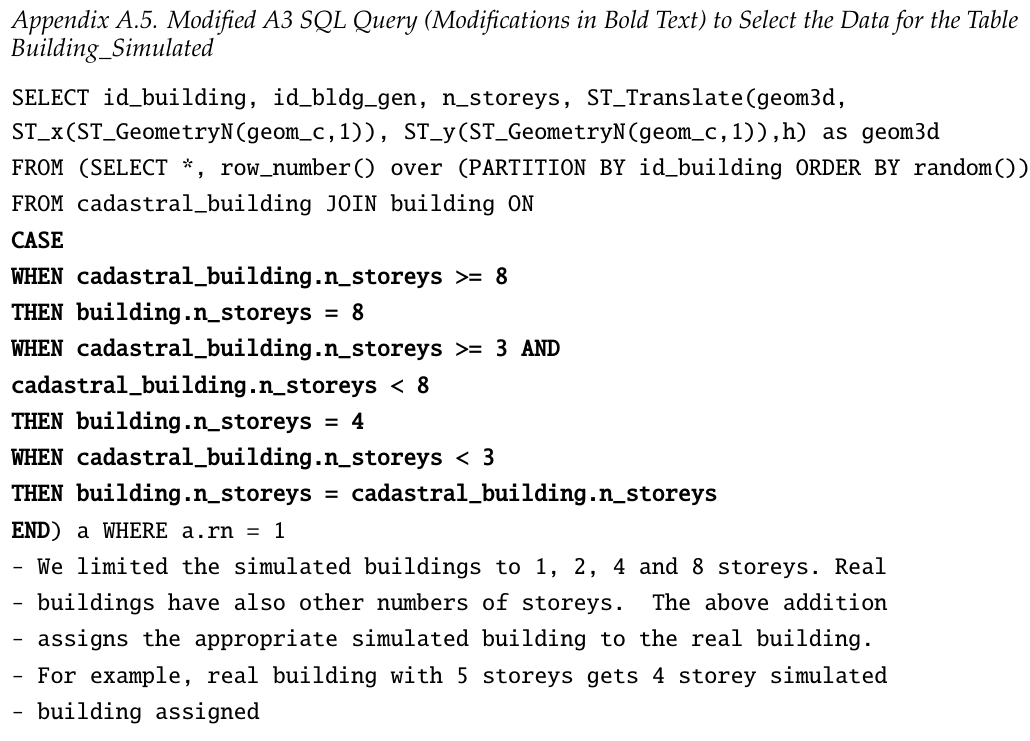
(cid:21) building table, we join building_simulated table (cid:21) We can join the corresponding room geometries of the assigned (cid:21) simulated